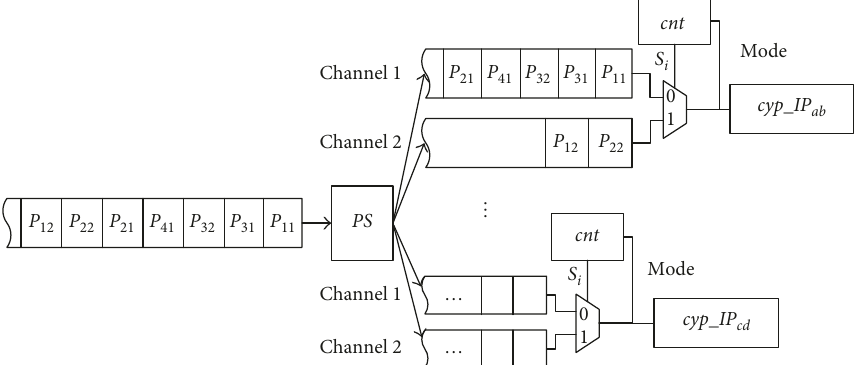
Figure 6: Parallel scheduling and dual receiving channel of preprocessing